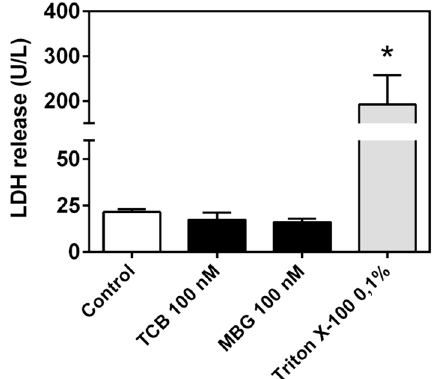
Figure 6. Lactate dehydrogenase (LDH) release from LLC-PK1 cells treated with telocinobufagin (TCB) or marinobufagin (MBG). Serum-starved LLC-PK1 cells were treated with 100 nM TCB or 100 nM MBG in 2.5% FBS for 72 h. Data are the mean ± SEM of three independent experiments in duplicate. * p < 0.05 vs. control. Triton X-100 was used as positive control.